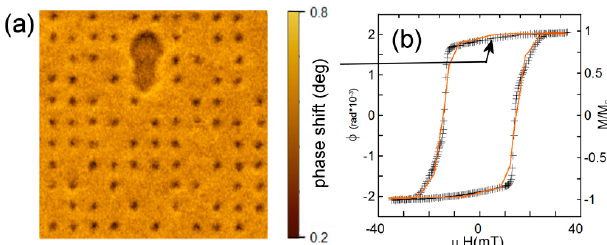
Figure 2. (Color online) ( a ) 2 × 2 μ m 2 MFM image of the remnant magnetic state of the sample irradiated with the uniform He + ion fluence (2.5 × 10 15 ions/cm 2 ) within a spot. ( b ) Magnetization hysteresis loop of the same structure. Crosses are the experimental data. The orange solid line is the loop obtained using numerical simulations.